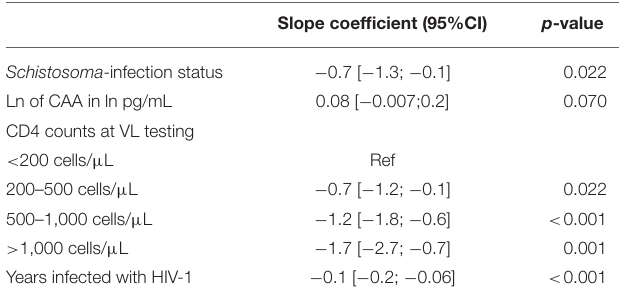
TABLE 3 | Results of the multivariable linear regression with log 10 of viral load as a continuous outcome. Slope coefficient (95%CI)